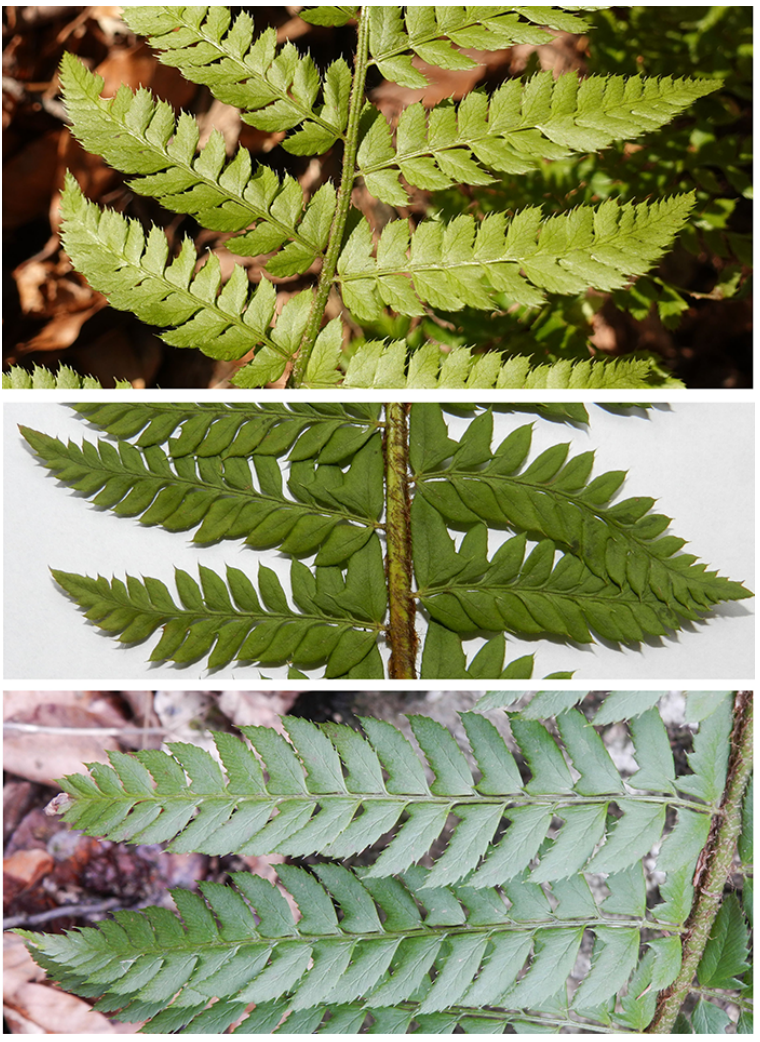
Figure 3 Leaf fragments of Polystichum setiferum (top) and P. aculeatum (middle) from Mt Czupel, as well as that of P. aculeatum var. aristatum Christ. (bottom) from Mt Jasieniowa in the Pogórze Cieszyńskie